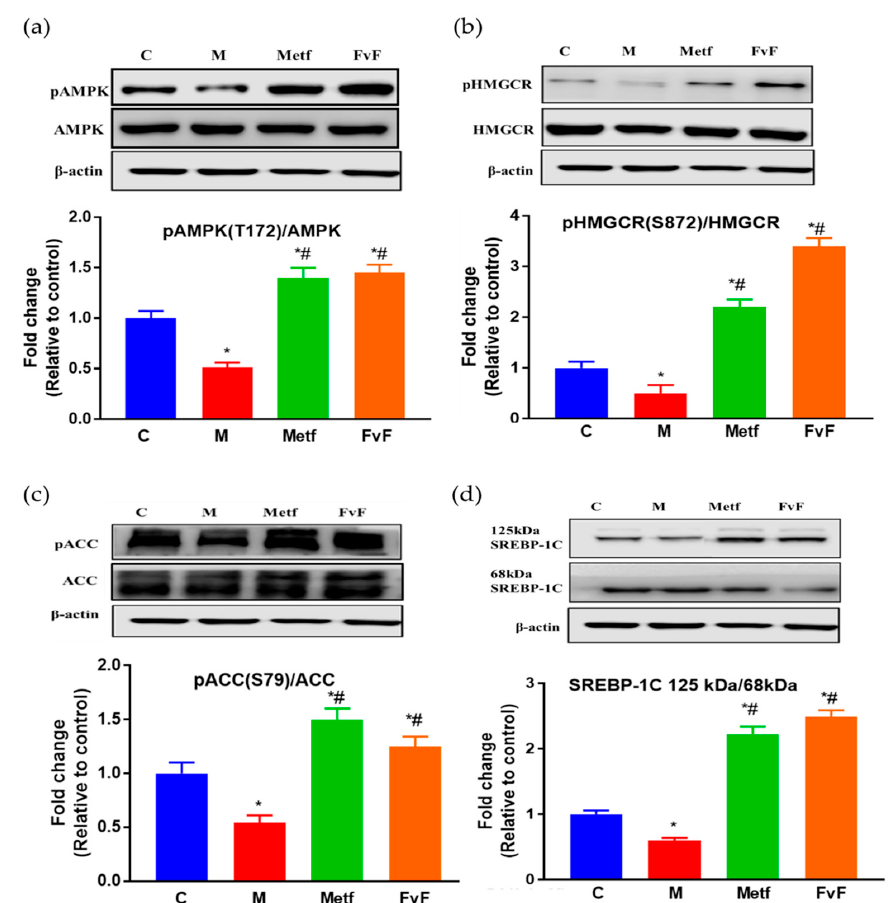
Figure 2. The effects of fucoidan from Fucus vesiculosus (FvF) on the adenosine 5 ′ -monophosphate- ativated protein kinase (AMPK) signaling pathway. The effects of FvF on the regulation of pAMPK ( a ), phosphorylation of HMG-CoA reductase (pHMGCR) ( b ), phosphorylation of acetyl-CoA carboxylase (pACC) ( c ), and sterol-regulatory element-binding protein-1c (SREBP-1C) ( d ). C, control group; M, cells treated with 100 µ M PA for 24 h; Metf and FvF, cells treated with 100 µ M sodium palmitate (PA) for 24 h then incubated with metformin (2 mM) or FvF (100 µ g / mL) for another 6 h. SREBP-1C